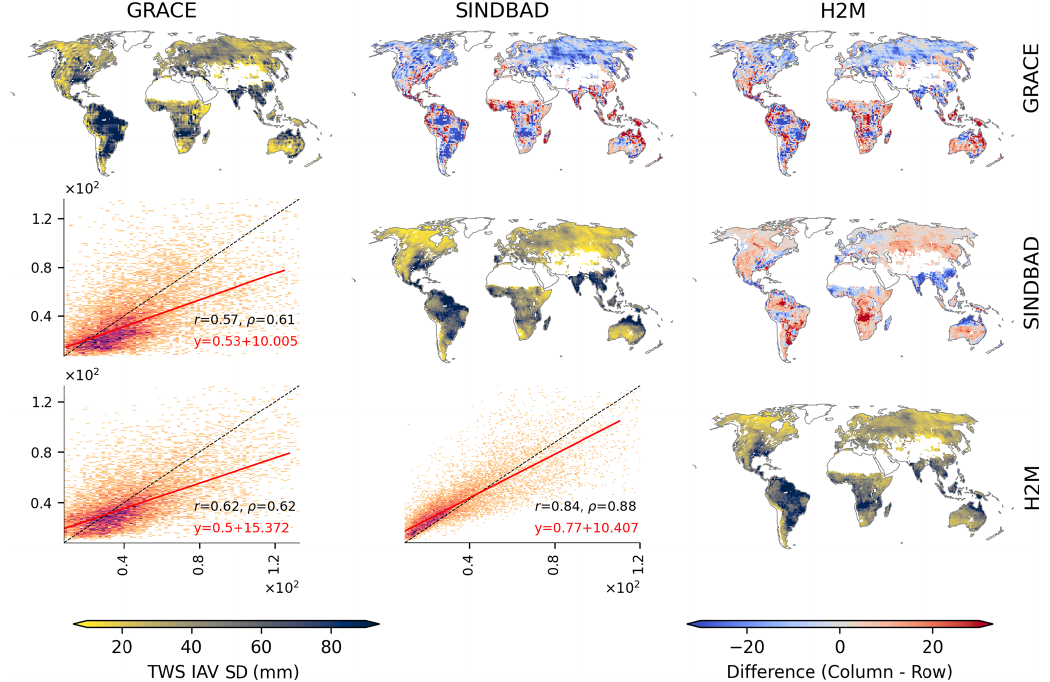
Figure B4. Same as Fig. 3 but for the standard deviation (SD) of the global terrestrial water storage (TWS) interannual variability (IAV) instead of the pixel-wise contributions to the variance in the global TWS